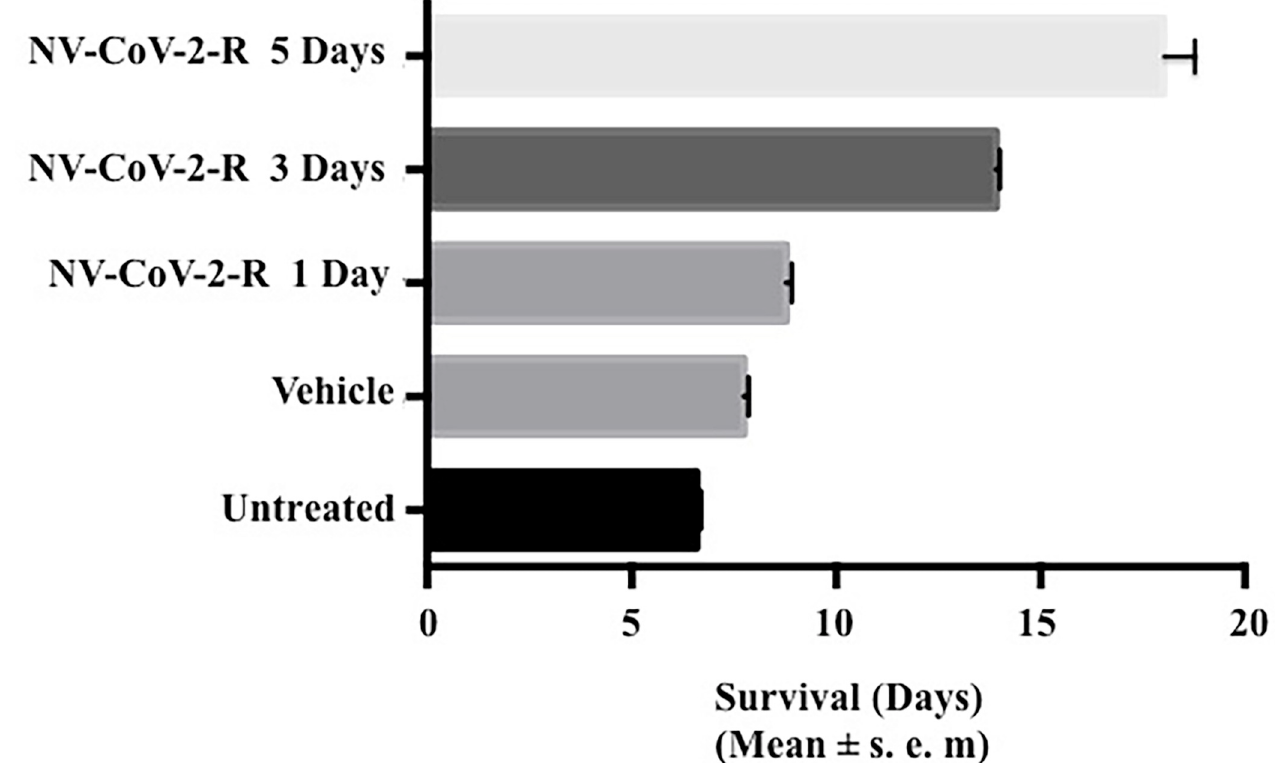
Fig 5. Survival rate of NL-63 infected male rats after treatment with NV-CoV-2 encapsulated RDV (NV-CoV-2-R).